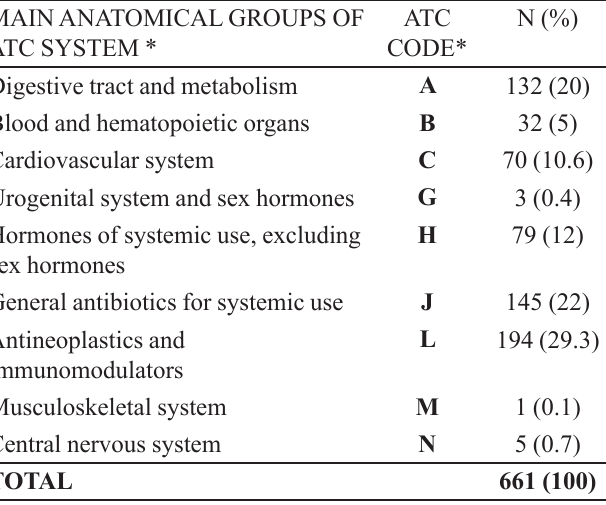
TABLE I - Epidemiological characteristics of patients seen by the Pharmaceutical Care Service for kidney and liver transplant patients. April – October/2011, Fortaleza –Ceará